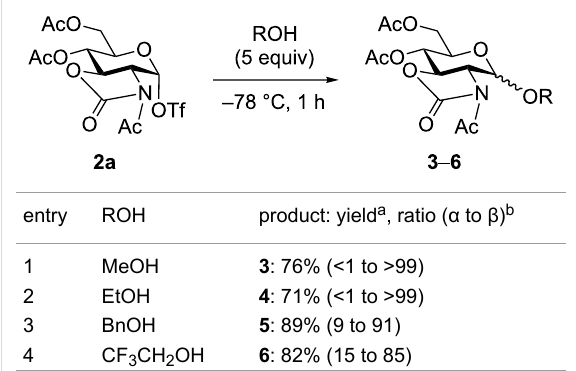
Table 2: Glycosylation of electrochemically generated glycosyl triflate 2a